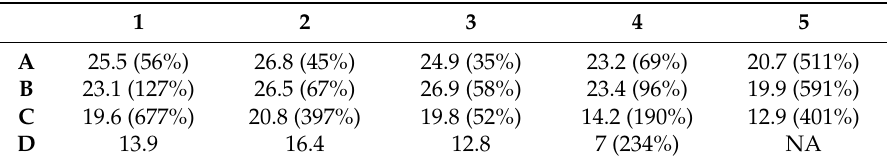
Table 8. SNR (dB) for Pulsed Phase Thermography (PPT) data.